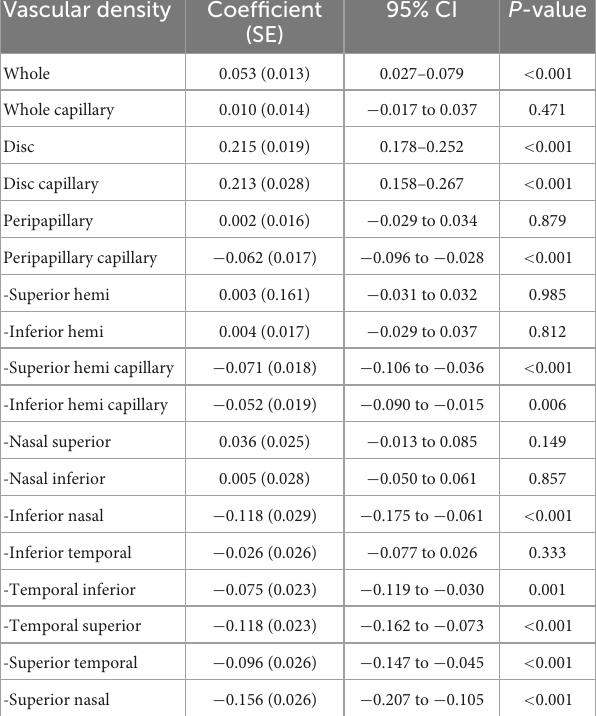
TABLE 5 Effect of age on the repeatability measurement of the papillary and peripapillary vascular